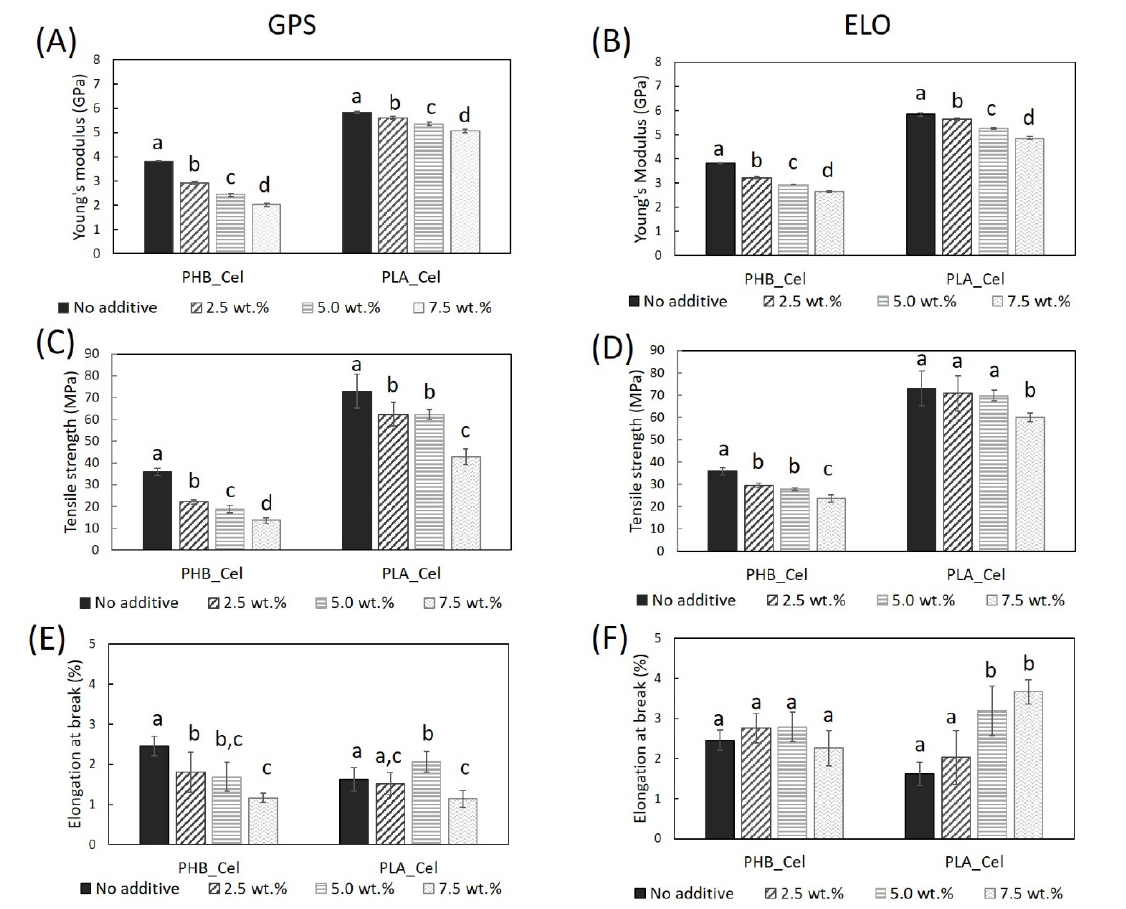
Figure 3. Tensile mechanical properties of the PHB- and PLA-based composites without additives and with GPS ( A , C , E ) and ELO ( B , D , F ) additives. Different letters (a,b,c,d) indicate statistically sig- nificant differences ( p < 0.05).